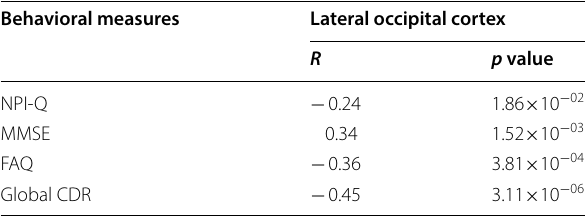
Table 4 Correlation value ( R ) and corresponding p -value for the association between behavioral measures and betweenness centrality of